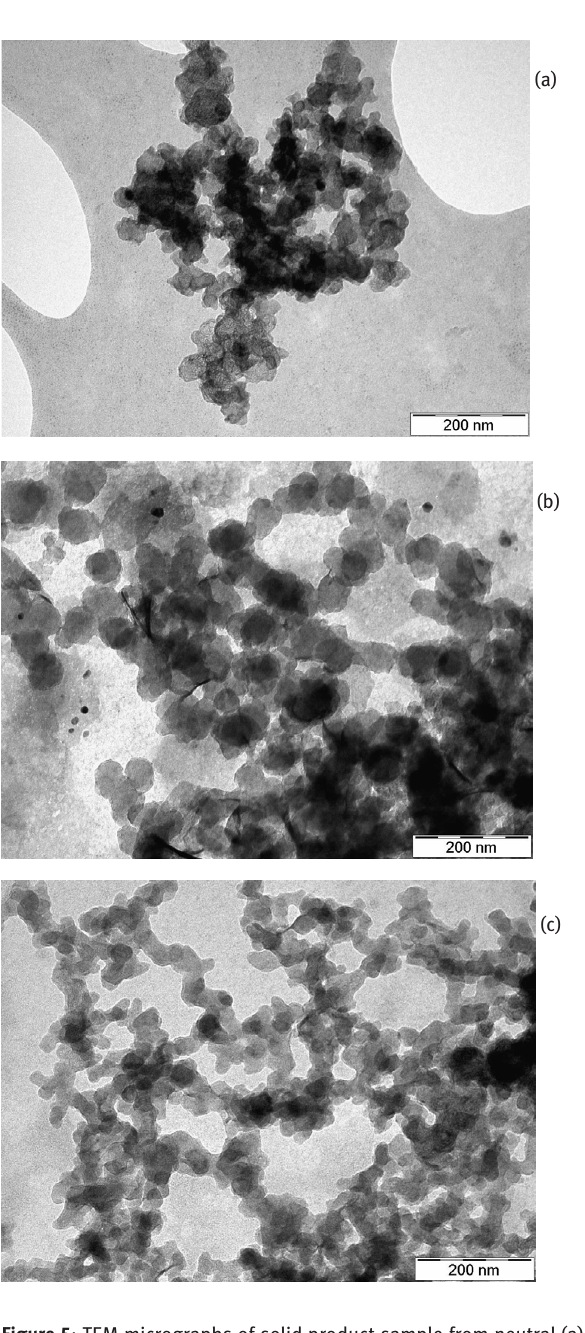
Figure 5 : TEM micrographs of solid product sample from neutral (a), oxidative (b) and reductive (c)